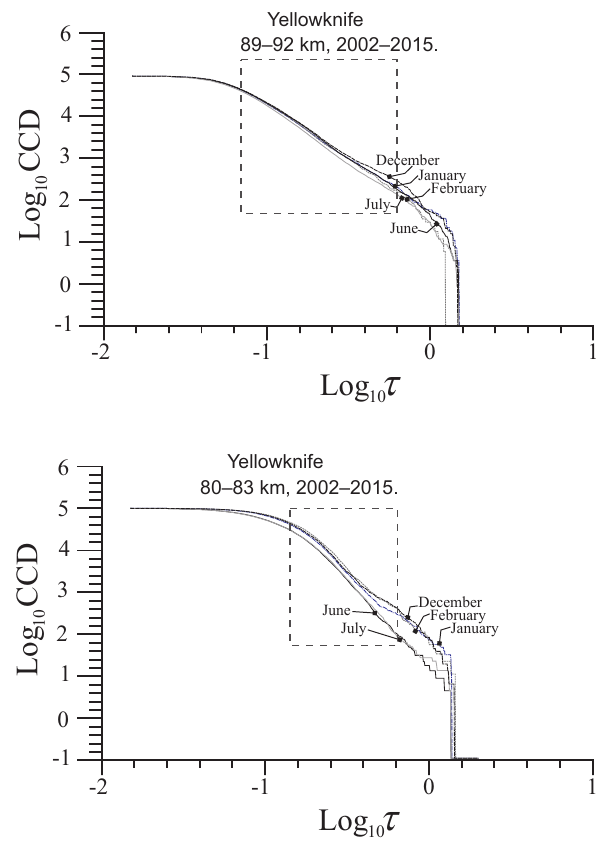
Figure 1. Complementary cumulative distributions of decay times for the Yellowknife site over a time period from 2002 to 2015 for summer (represented by June and July) and winter (represented by December to February), for heights of 89 to 92km and 80 to 83km. Values are normalized in such a way that the total number of detec- tions is treated as 100000 meteors, which is representative of the number of meteors detected in a 3km deep bin at 89 to 92km for the month of June over the full time interval. At other heights and in other months the number can be lower by 5 to 10 times, but the nor- malization allows easy comparison between datasets. The knees in the plots are taken to have a line density of 2.4 × 10 14 electronsm − 1 (see Appendix C), and meteors to the right of the boxed areas shown have line densities up to 3 × 10 15 electronm − 1 . See text for more